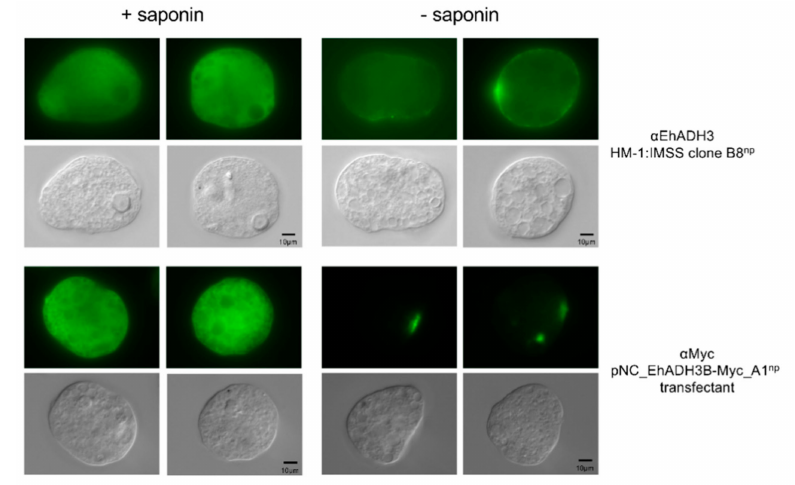
Figure 6. Localization of EhADH3B b in clone B8 np using polyclonal EhADH3B b antibodies in and A1 np transfectants expressing EhADH3B b as c-myc fusion protein using anti c-myc for detection. Trophozoites were fixed with paraformaldehyde and treated with ( + ) or without ( − ) saponin. Afterwards, the trophozoites were incubated with specific antiserum (diluted 1:200 in NaPBS ± saponin), followed by Alexa Fluor ® 488 goat anti-mouse secondary antibody. Localization was assessed by fluorescence microscopy (Leica, DM BR, Wetzlar, Germany).